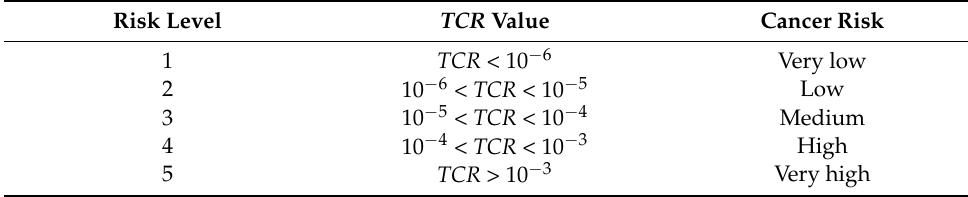
Table 5. Carcinogenic risk assessment scale